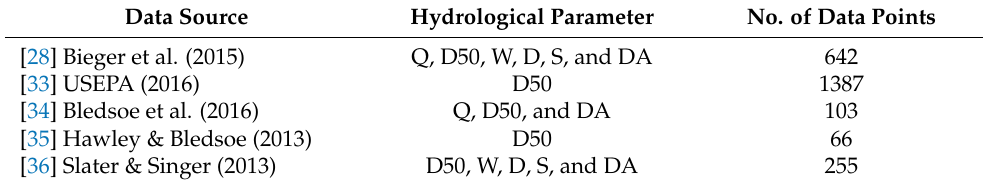
Table 1. D50 data sources with other hydrological parameters. Data Source Hydrological Parameter No. of Data